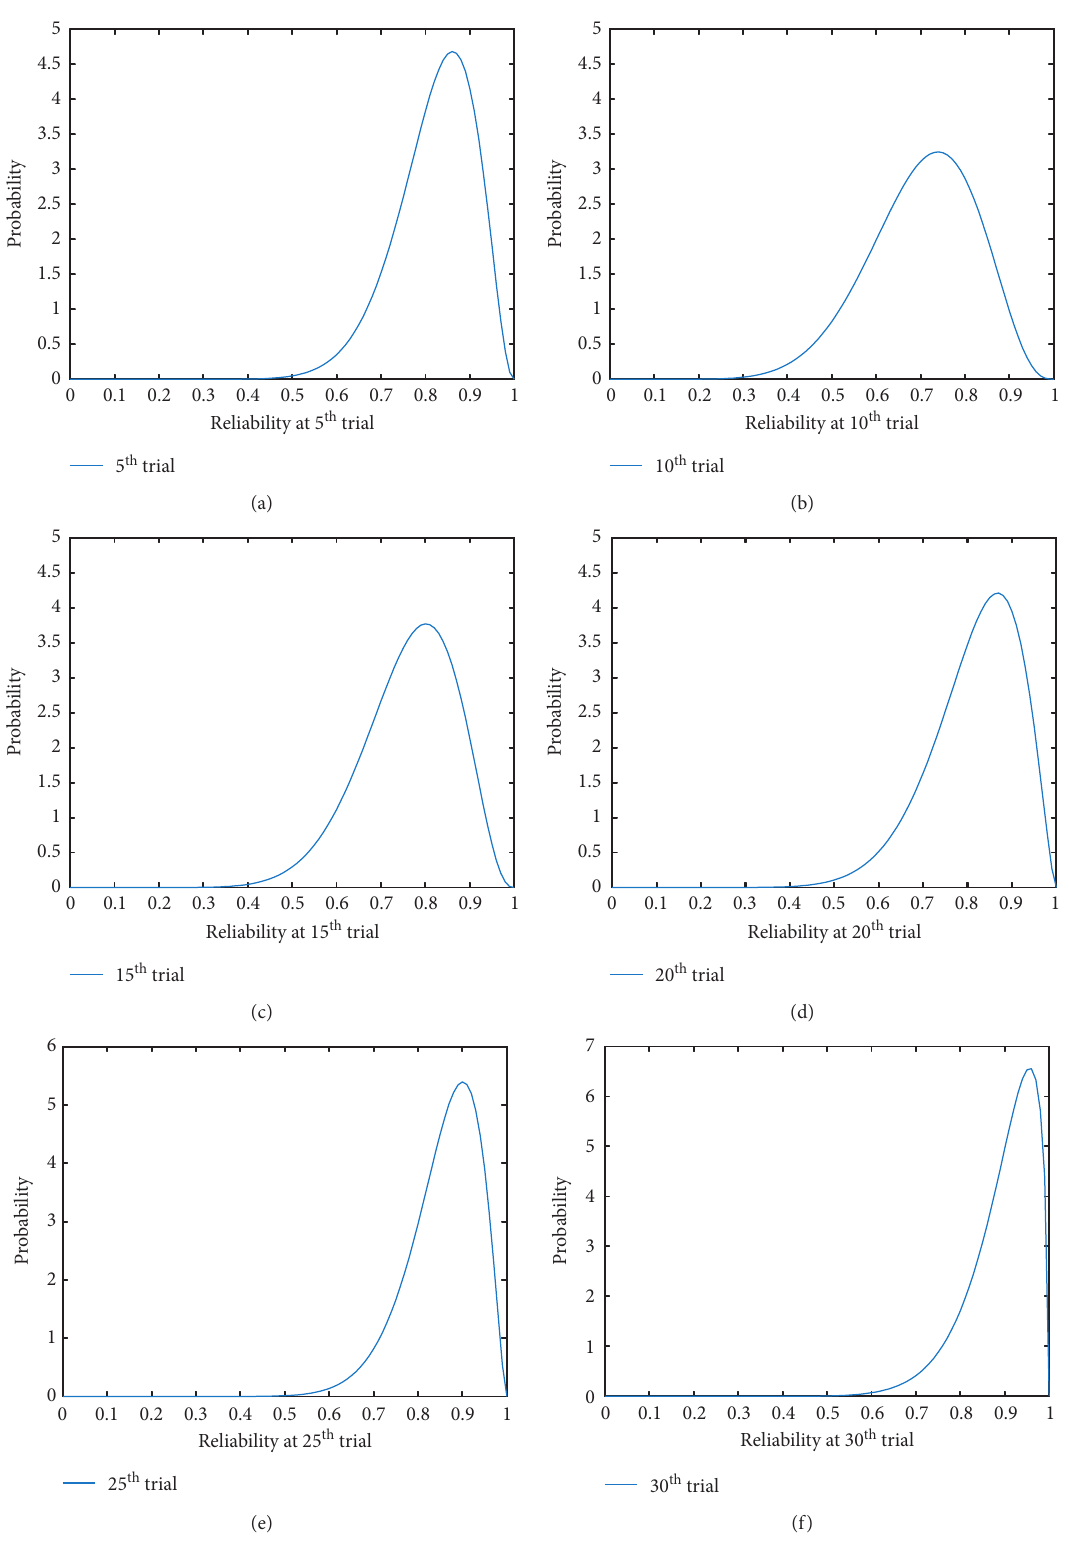
Figure 4: Reliability prediction at each trial. (a) Reliability estimated at the 5th trial. (b) Reliability estimated at the 10th trial. (c) Reliability estimated at the 15th trial. (d) Reliability estimated at the 20th trial. (e) Reliability estimated at the 25th trial. (f) Reliability estimated at the 30th